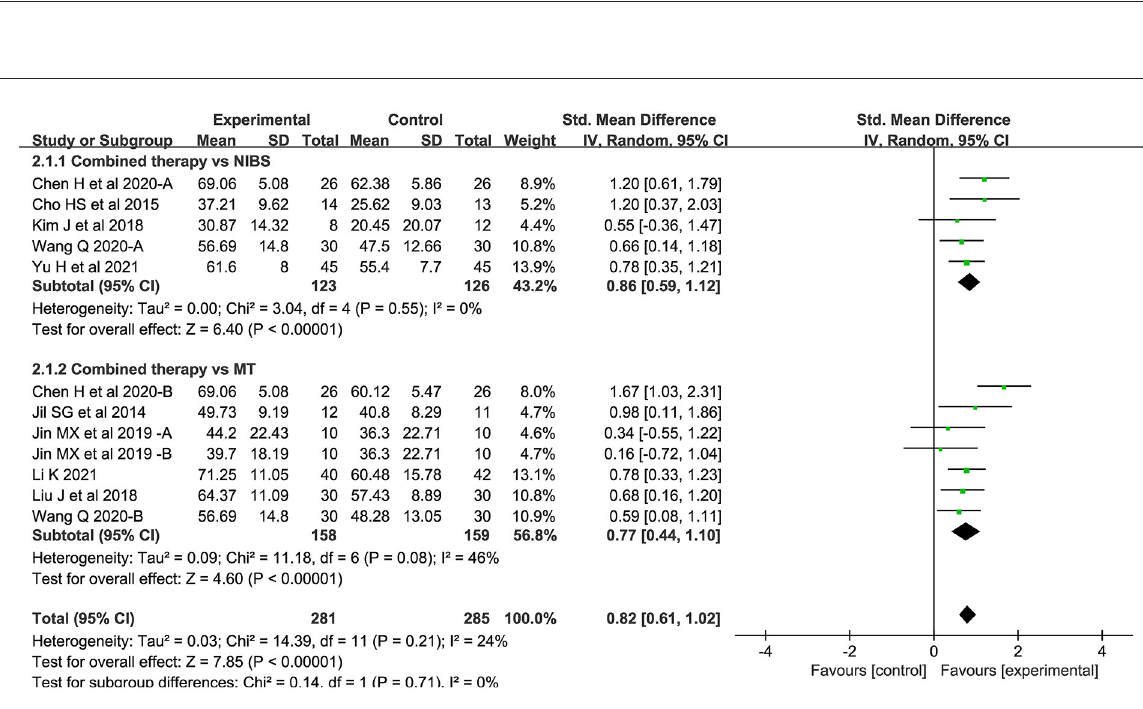
FIGURE4 Forest plot of trails comparing NIBS combined with MT vs. NIBS or MT alone for activity